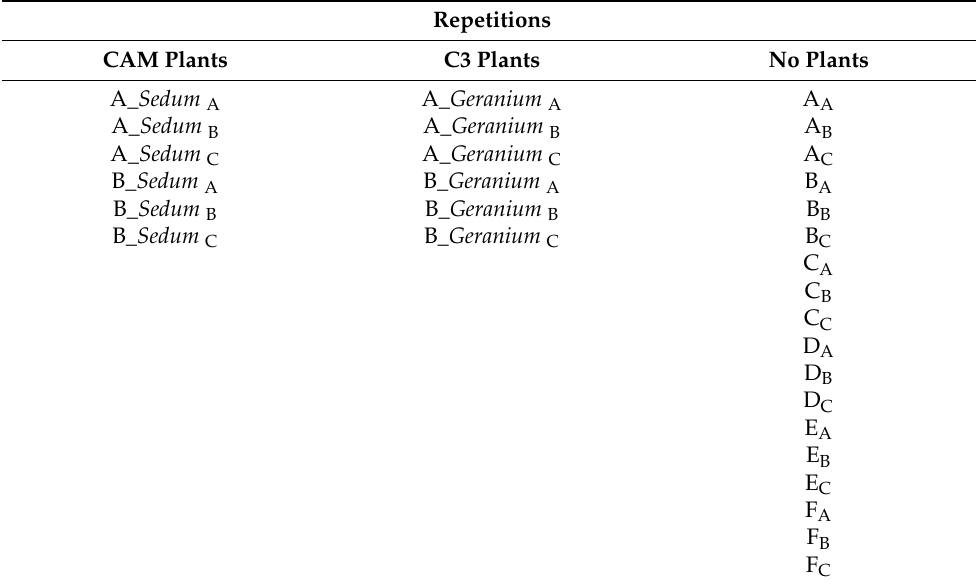
Table 3. Overview of the different combinations of technical soils (A-F). Each technical soil is filled into three 10 L plant containers with three replicates (a–c) with CAM plants, C3 plants, and no plants (based on Weiss, 2017